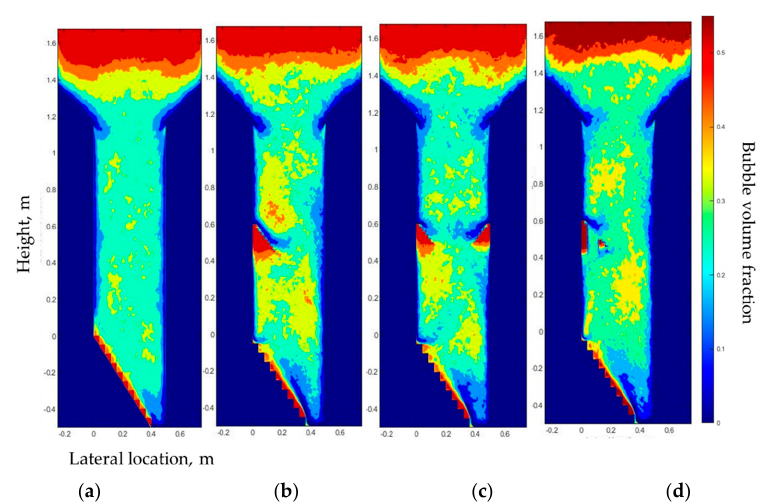
Figure 7. Gas holdup contours in the entire fluidized bed reactor with and without baffle and regular fluxtube under the superficial gas velocity of 0.4 m/s using the even case inlet configuration. ( a ) Without baffle; ( b ) Asymmetrical baffle; ( c ) Symmetrical baffle; ( d ) Asymmetrical baffle with the regular fluxtube.